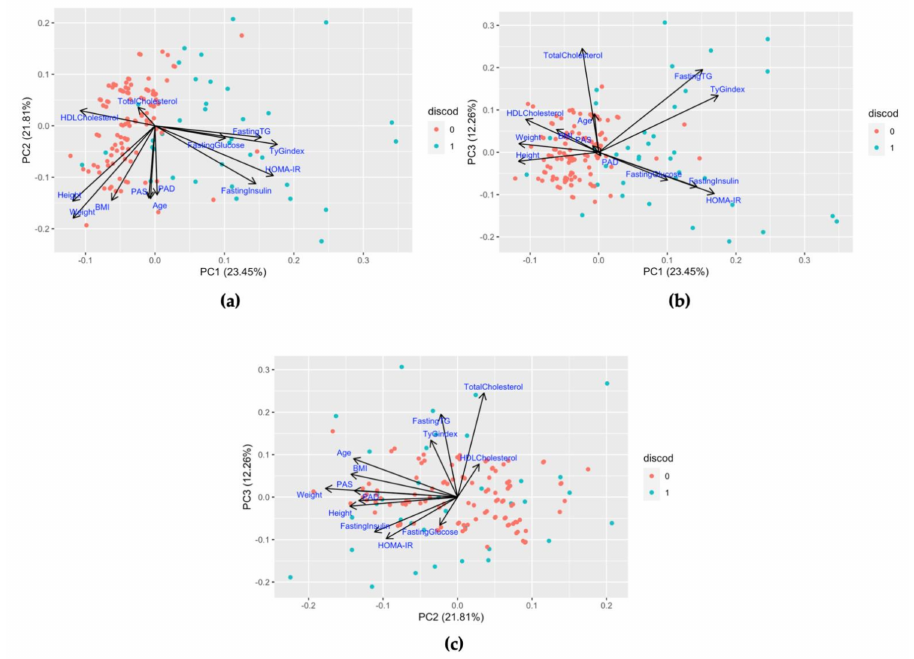
Figure 2. The panel shows biplot graphs in which the observations of the merged dataset are scattered in a two-dimensional plane defined by the PCs. The projections of the variables under examination in the analysis are shown as black arrows and are labeled. The observations derived from the healthy control group are in red, whereas those of the children-with-disabilities group are in blue. It is clear that when considering the plane defined by the PC1 and PC2 ( a ) or by the PC1 and PC3 ( b ), we note that the observations from the healthy control children group cluster together in a region of the plane where the PC1 is negative, whereas observations relating to the children with disabilities group are more dispersed in the direction of the projection of the variables related to insulin resistance and glucose metabolism. By excluding the PC1 and considering the PC2 and PC3 ( c ), the observations are found to be mixed, highlighting the fact that the PC1, characterized by the variables related to insulin resistance and glucose metabolism, is crucial in differentiating the two